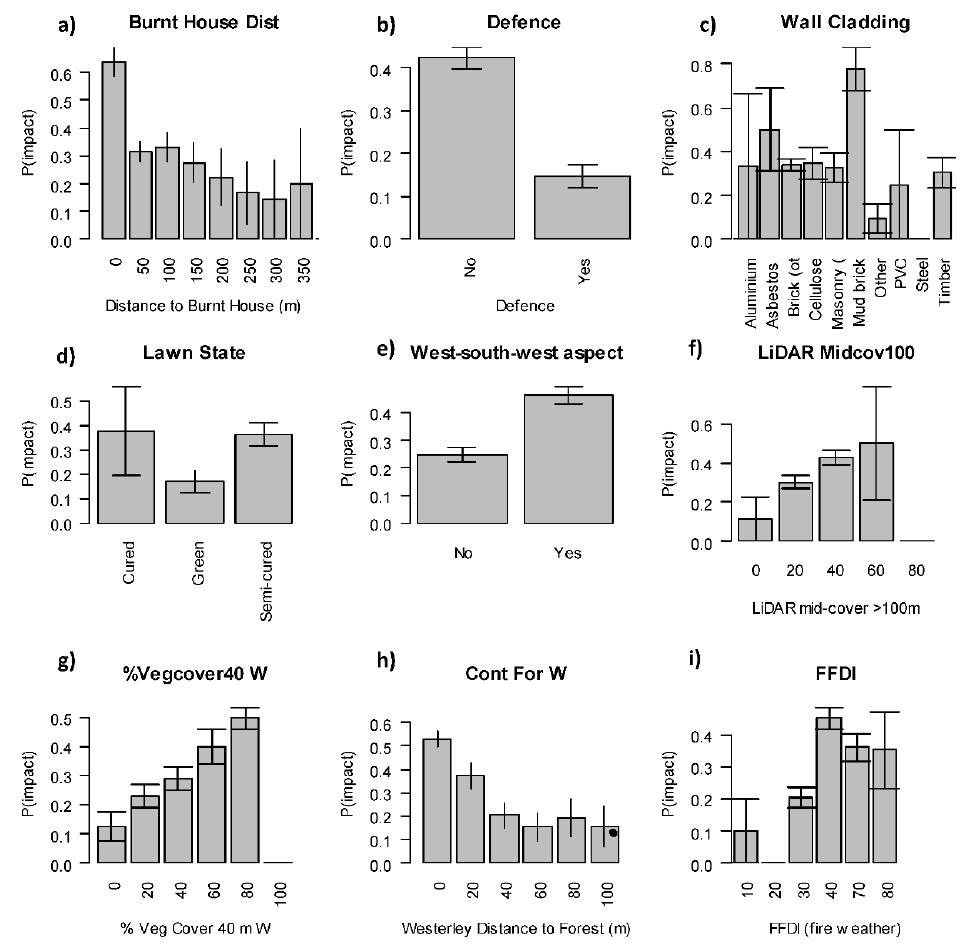
Figure 5. The proportion of houses impacted for selected predictors in the univariate analysis. Each plot ( a – i ) shows the proportion of houses impact for different levels of the selected predictor. Predictors were selected because they were important in the Random Forest or univariate models, or represented the six themes. The dot in ( h ) is the mean impact for cases with >100 m distance ( n = 103).